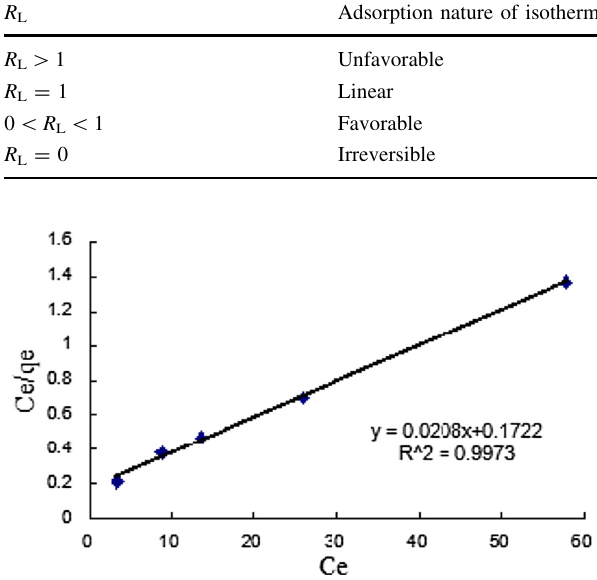
Fig. 6 Langmuir isotherm representing the variation of specific adsorption ( C e / q e ) against the equilibrium concentration ( C e ) for adsorption of As(III) onto MPKSF